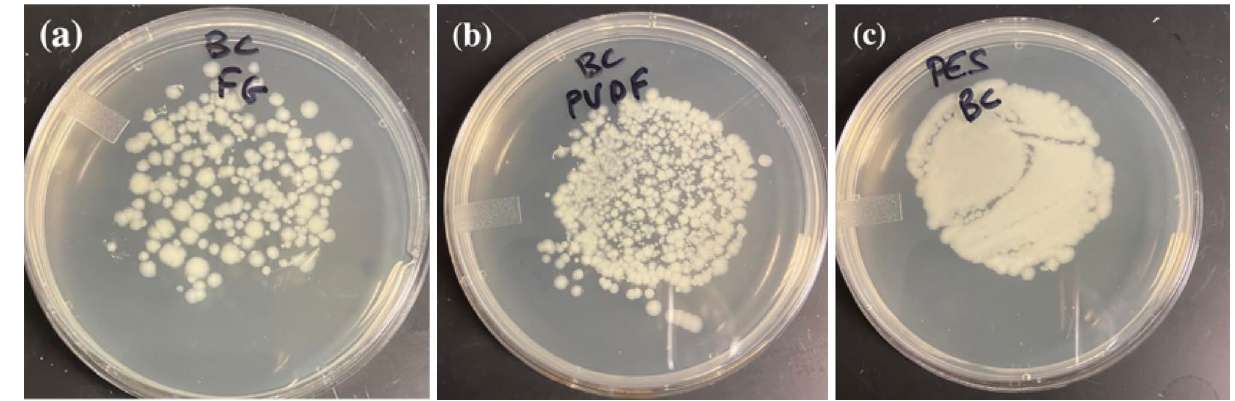
Figure 3. Images of stamp-grown B. cereus spores from backwashed FG ( a ), PVDF ( b ) and PES ( c ) filters used to retain spores from 250 mL suspensions at 1 × 10 2 spores/mL.